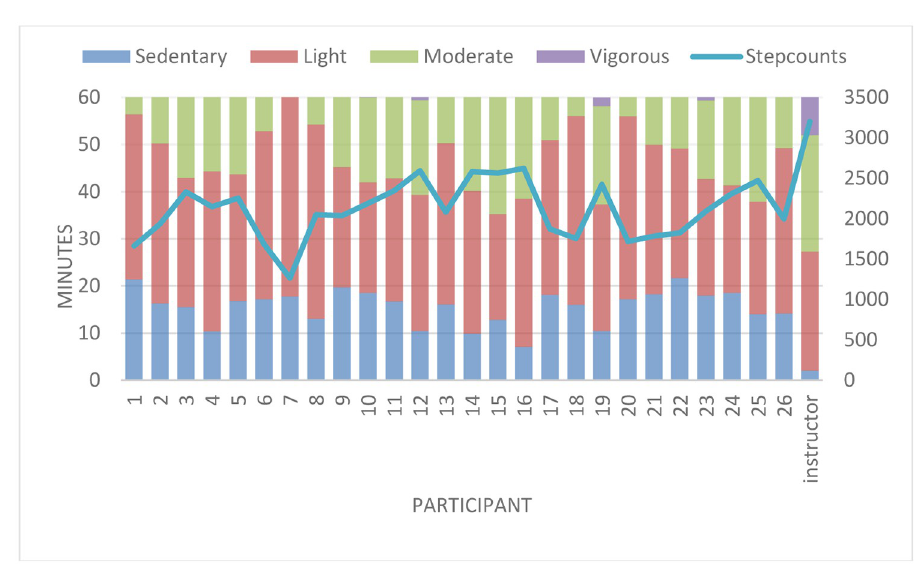
Fig 2. Steps and averaged sedentary, light, moderate and vigorous intensity for each participant: All attended sessions.